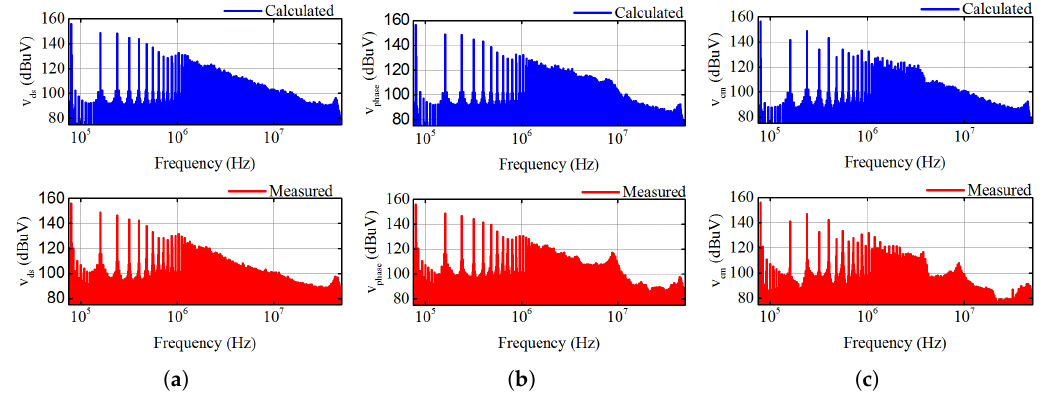
Figure 12. Calculated and measured spectra of v ds , v phase and v cm : ( a ) v ds , ( b ) v phase , ( c ) v cm .